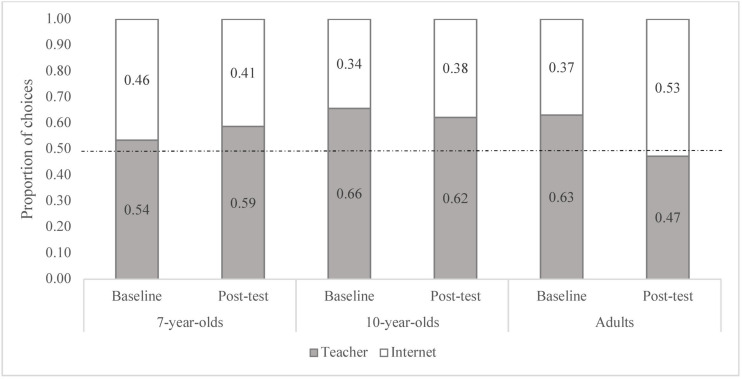
Proportion of responses siding with the teacher and the Internet for each age group during baseline and post-test phases.